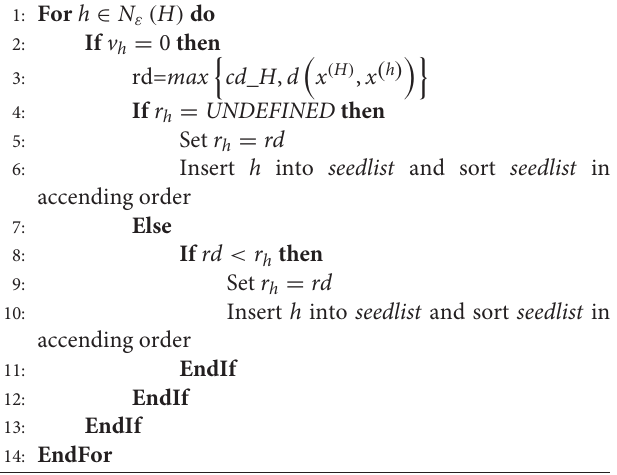
Algorithm 2 : The procedure of insertlist ()